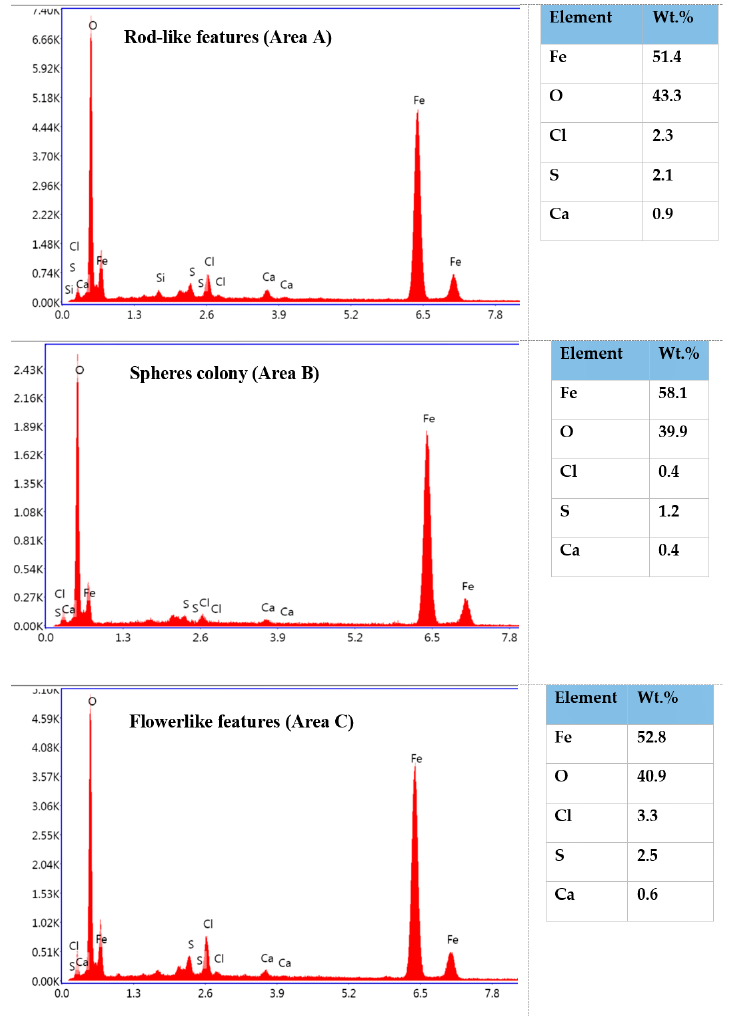
Figure 6. Energy dispersive X-ray spectroscopy (EDS) analyses of areas shown in Figure 5, related to rod-like, spherical, and flower-like features ( x -axis: Energy (KeV), y -axis: a.u.).